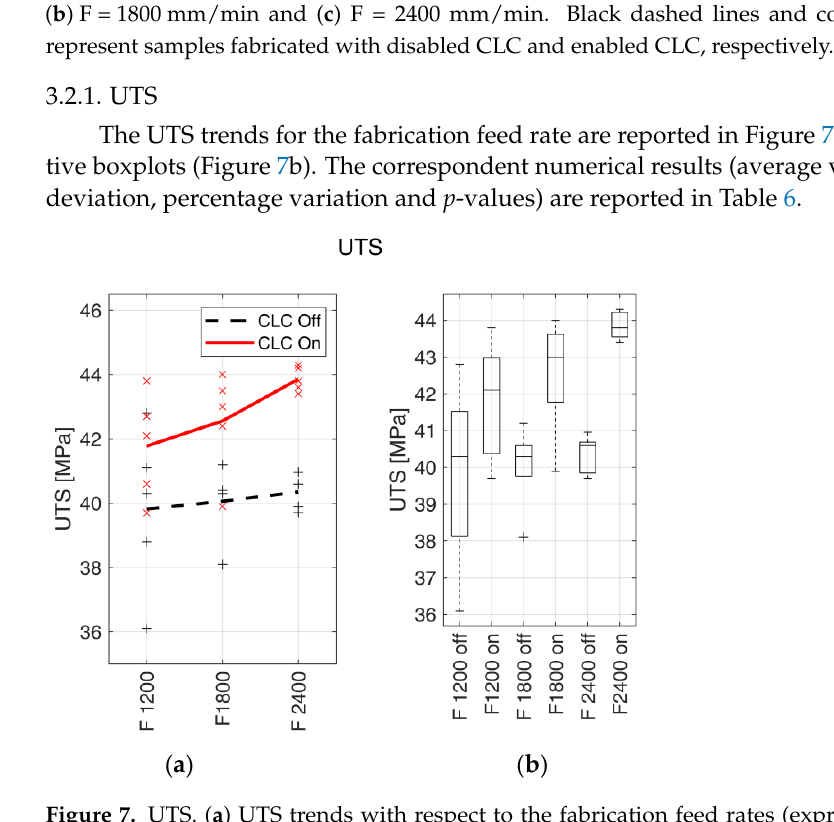
Table 6. UTS values.